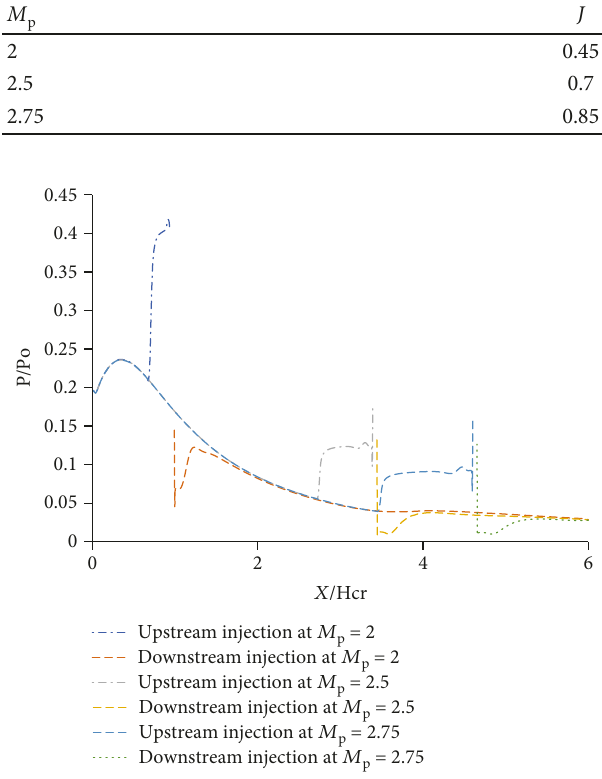
Table 4: Momentum fl ux ratio J with injection angle at M